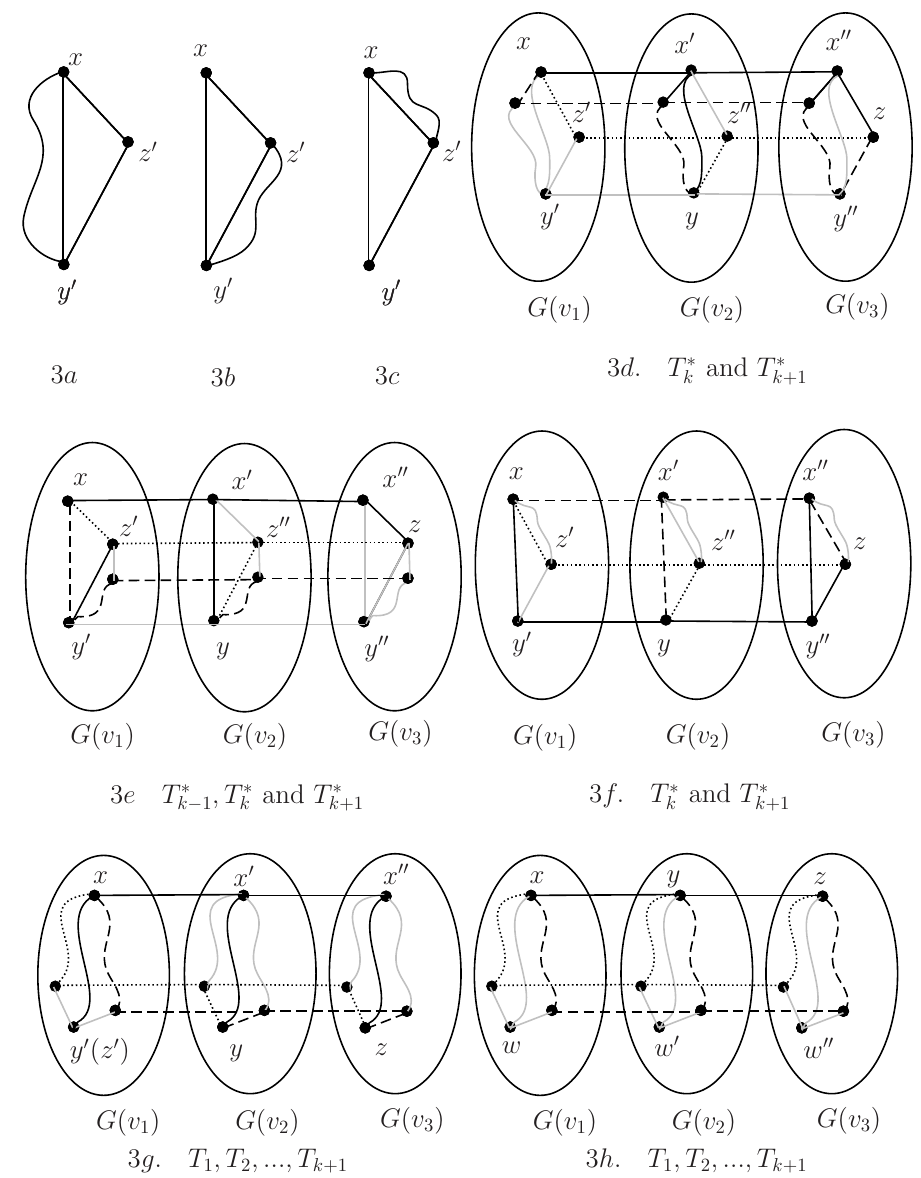
Fig. 3: The edges (or paths) of a tree are shown by the same type of lines. The lightest lines stand for edges (or paths) not contained in T ∗ i